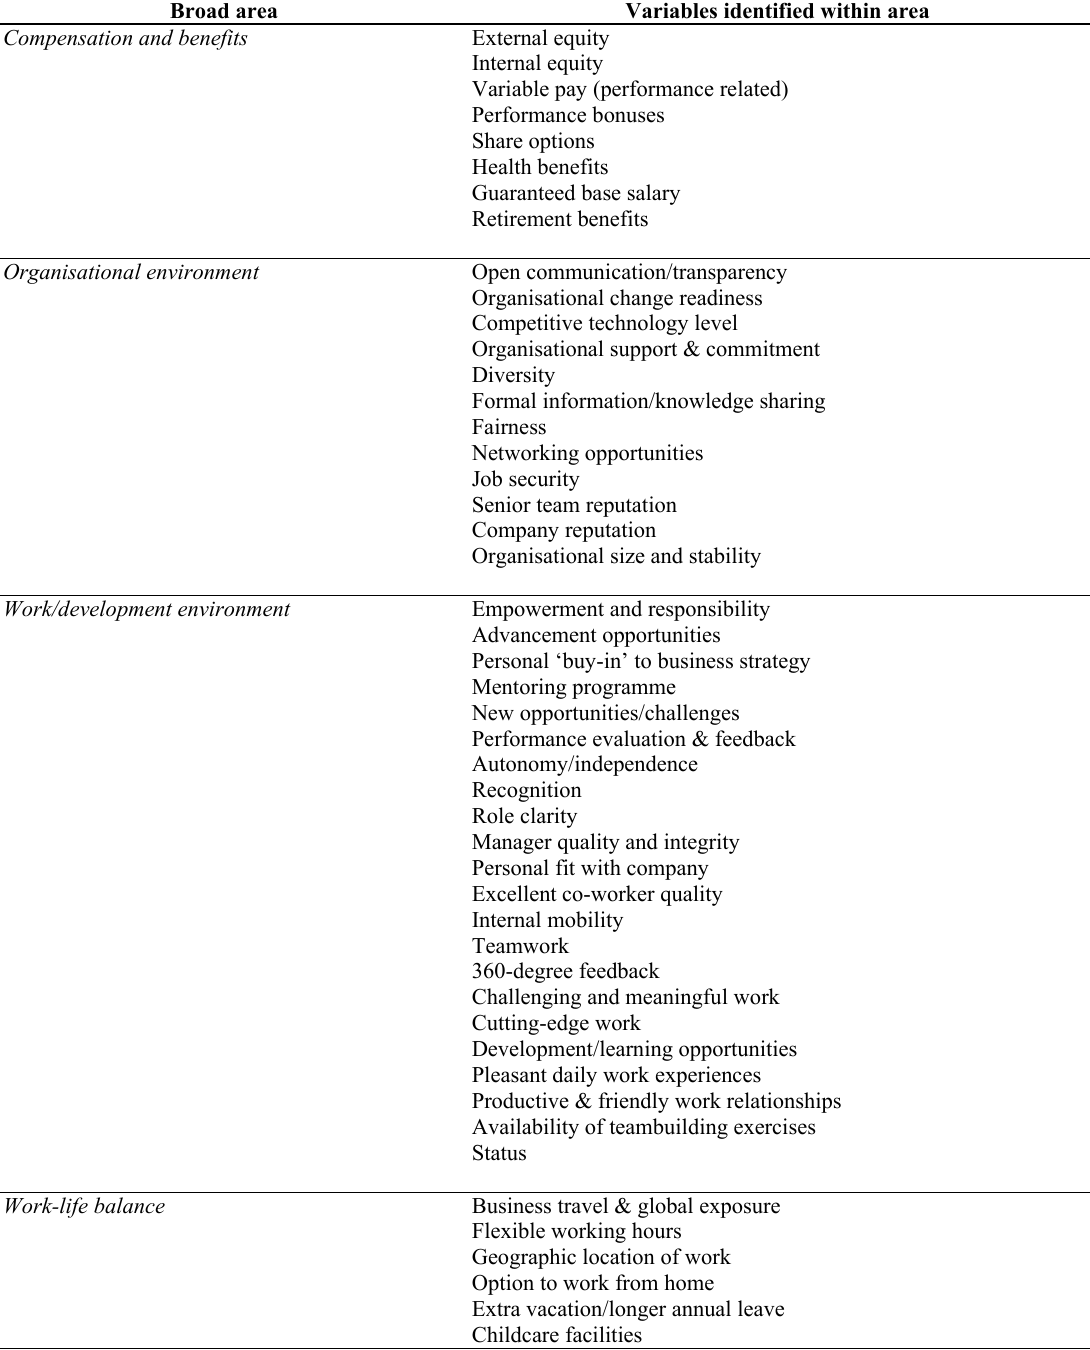
Table 1: Variables valued by talented employees Broad area Variables identified within area Compensation and